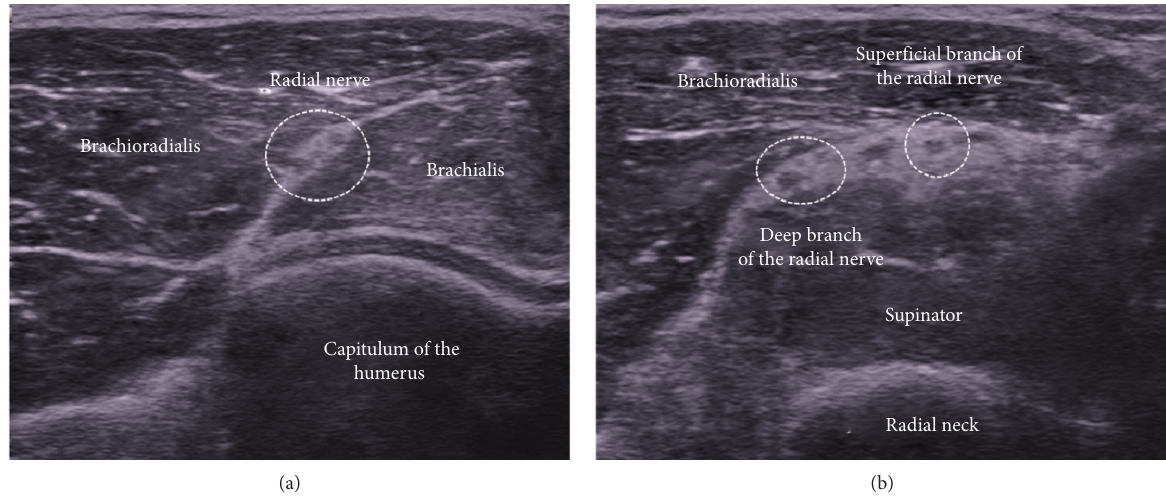
Figure 8: In the anterolateral short-axis view of the elbow joint level, the radial nerve is visible as a fascicular pattern between the brachioradialis and brachialis muscles. The radial nerve is divided into deep and superficial branches at the radial neck level. It is also possible to block only the superficial branch, which is the sensory